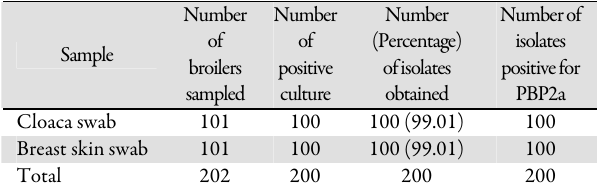
Table 2. Isolation rates of methicillin-resistant Staphylococcus species from broilers Number Number (Percentage) of isolates obtained Sample of isolates obtained MRCoPS MRSA MRCoNS Cloaca swab 100